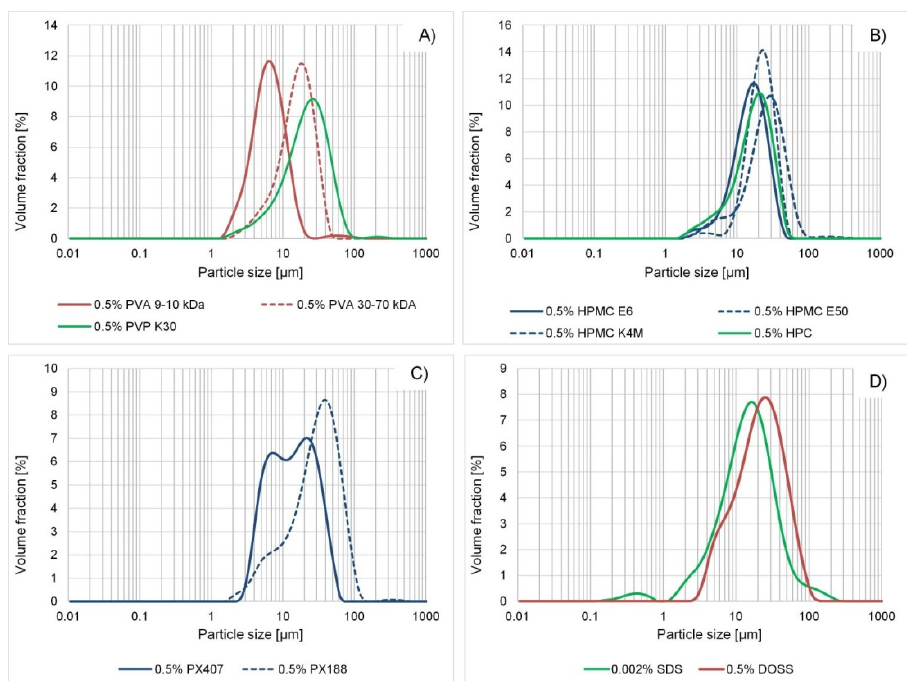
Figure A3. ( A – D ) Particle size distribution curves of cilostazol precipitated from 10% DMSO with different single stabilizers during stabilizer screening stage.